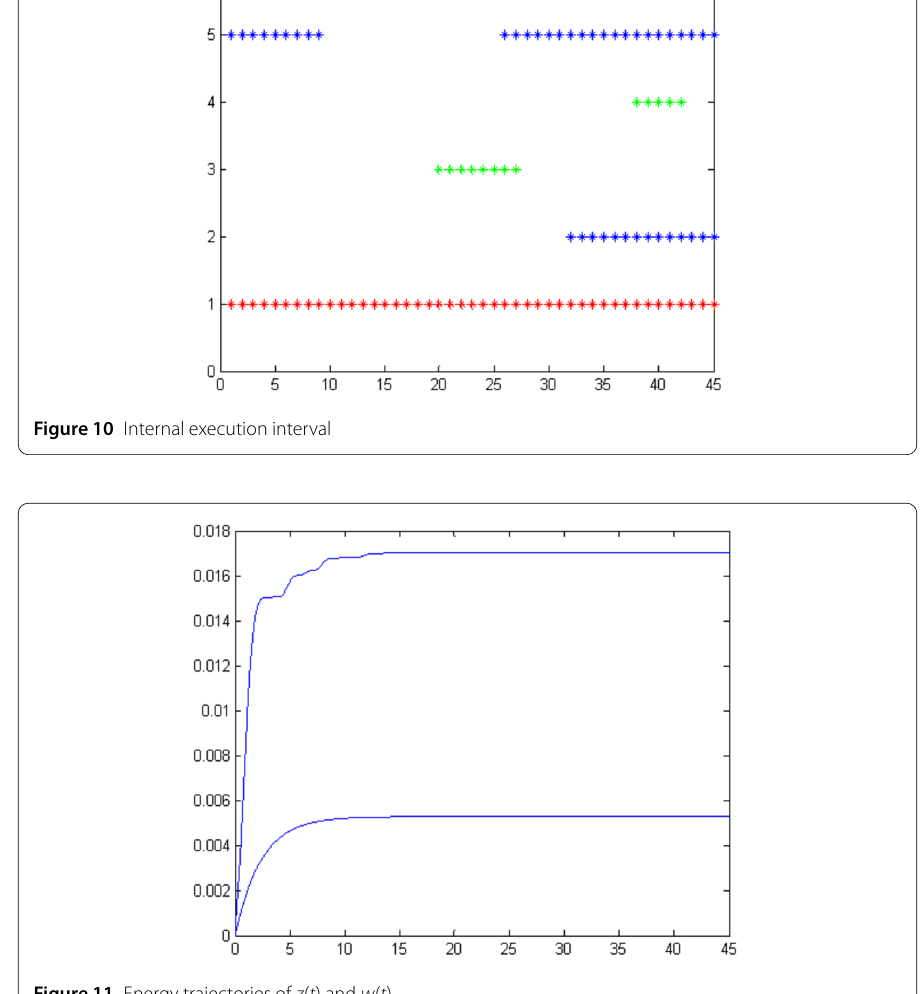
Figure 11 Energy trajectories of z ( t ) and w ( t